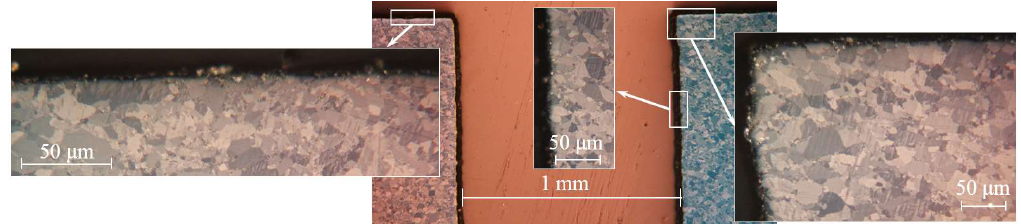
Figure 8. Microstructure of the Be-4 sample cross section (360 °С, 100 cycles).